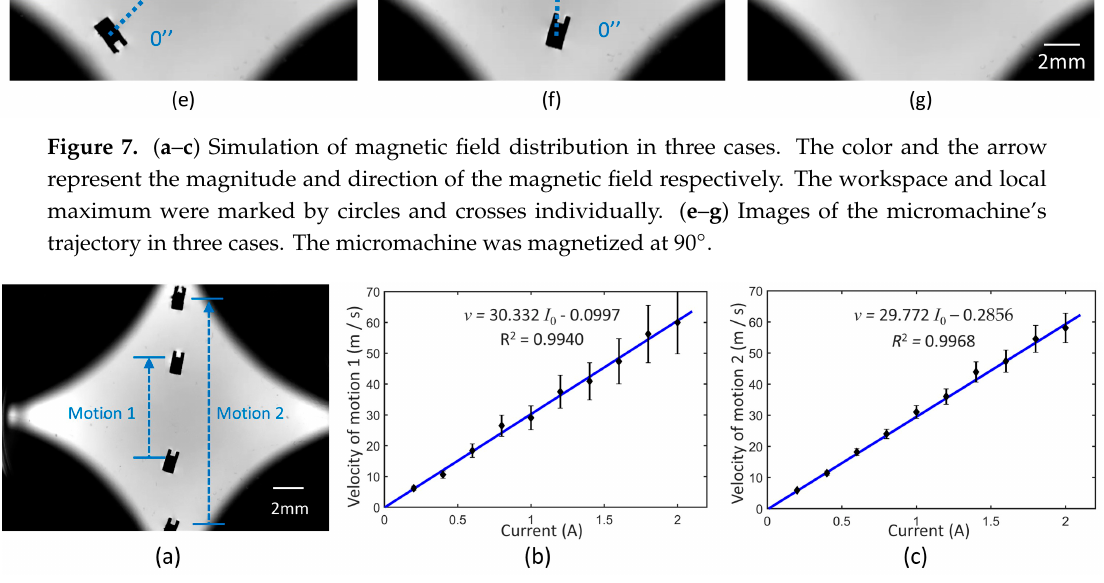
Figure 7. ( a – c ) Simulation of magnetic field distribution in three cases. The color and the arrow represent the magnitude and direction of the magnetic field respectively. The workspace and local maximum were marked by circles and crosses individually. ( e – g ) Images of the micromachine’s trajectory in three cases. The micromachine was magnetized at 90°.